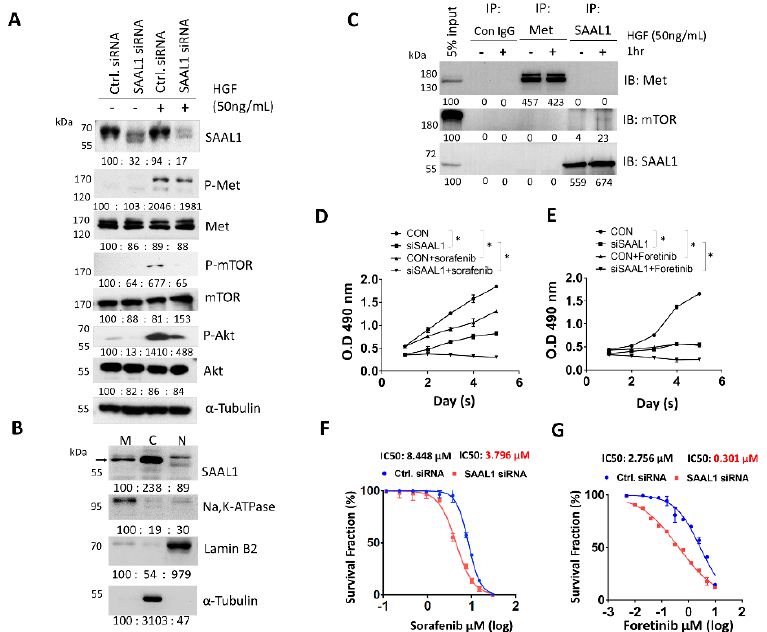
Figure 4. SAAL1 depletion sensitizes HCC cells to sorafenib and foretinib treatment through impairing HGF / Met-driven Akt / mTOR oncogenic pathway. ( A ) The e ff ect of SAAL1 depletion on the HGF-induced Met / Akt / mTOR phosphorylation cascade was analyzed by Western blotting analysis, α -tubulin was served as an internal control. ( B ) Subcellular localization of SAAL1 protein in SK-Hep1 cells was analyzed by Western blotting analysis, α -tubulin was served as an internal control. ( C ) Analysis of SAAL1-interacting proteins in the absence or presence of HGF stimulation. The control IgG (Con IgG) was used as a negative antibody control. A total of 25 µ g protein lysates were loaded and served as an input control for the co-IP experiment. SAAL1 and Met were immunoprecipitated with the specific IP antibody, respectively. ( D ) The e ff ect of sorafenib treatment on cell proliferation of SAAL1-depleted SK-Hep1 cells versus the control SK-Hep1 cells. Data are means ± SEM ( n = 3). * p < 0.05. ( E ) The e ff ect of foretinib treatment on cell proliferation of SAAL1-depleted SK-Hep1 cells versus the control SK-Hep1 cells. Data are means ± SEM ( n = 3). * p < 0.05. ( F ) Determination of the IC 50 value of sorafenib in SAAL1-depleted SK-Hep1 cells versus the control cells. ( G ) Determination of the IC50 value of foretinib in SAAL1-depleted SK-Hep1 cells versus the control cells. All experiments were performed in triplicates and were done at least three